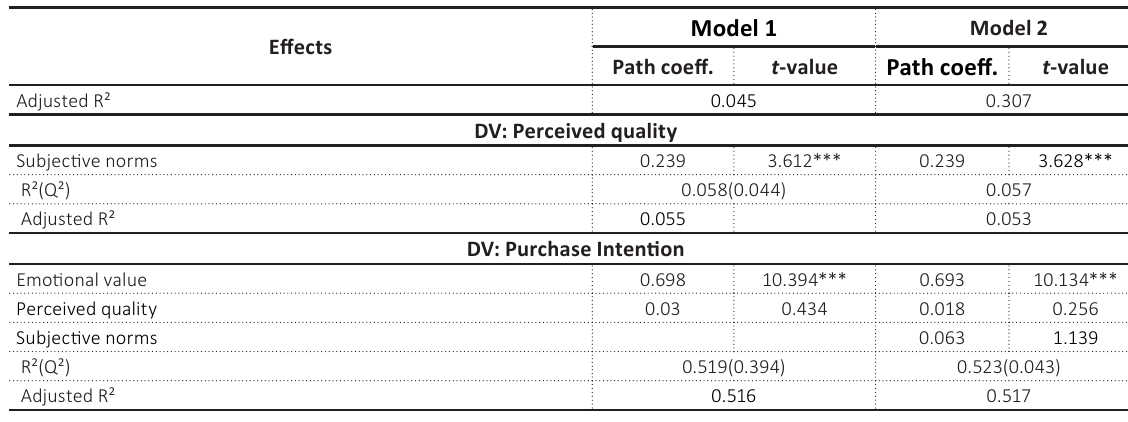
Table 3 (cont.). PLS results of the structural model